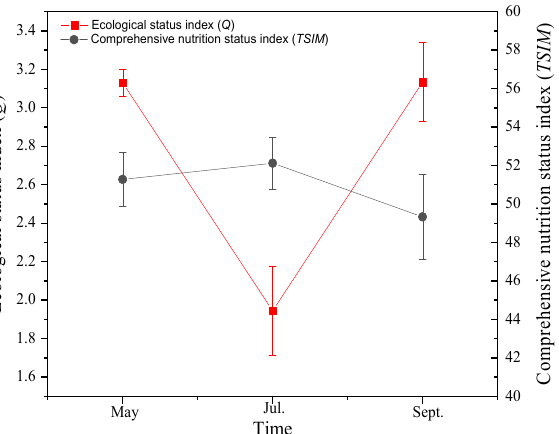
Figure 4. The temporal distribution of ecological status index ( Q ) and comprehensive nutrition status index ( TSIM ) ( ±